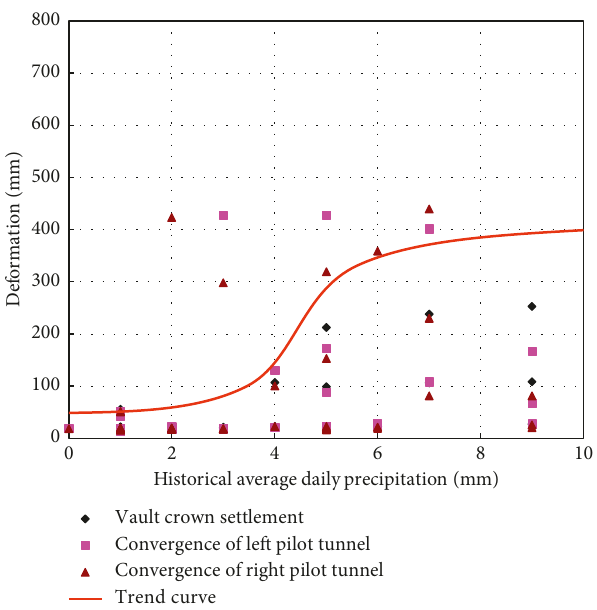
Figure 12: Relationship between surrounding rock and deformation daily